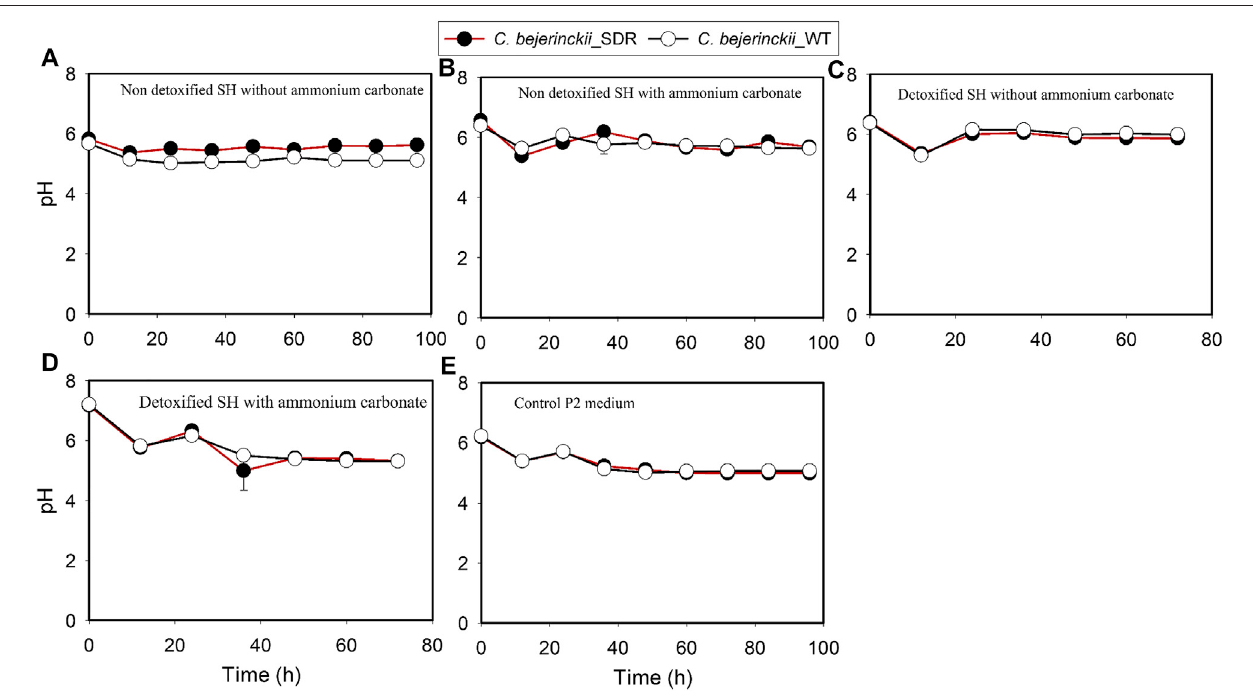
FIGURE 2 | pH pro fi les of the culture medium during fermentation of SH and P2 medium control by C. beijerinckii _SDR or C. beijerinckii _wildtype. (A) Non- detoxi fi edSHwithoutammoniumcarbonate. (B) Non-detoxi fi edSHwithammoniumcarbonate. (C) Detoxi fi edSHwithoutammoniumcarbonate. (D) Detoxi fi edSHwith ammonium carbonate. (E) Control P2